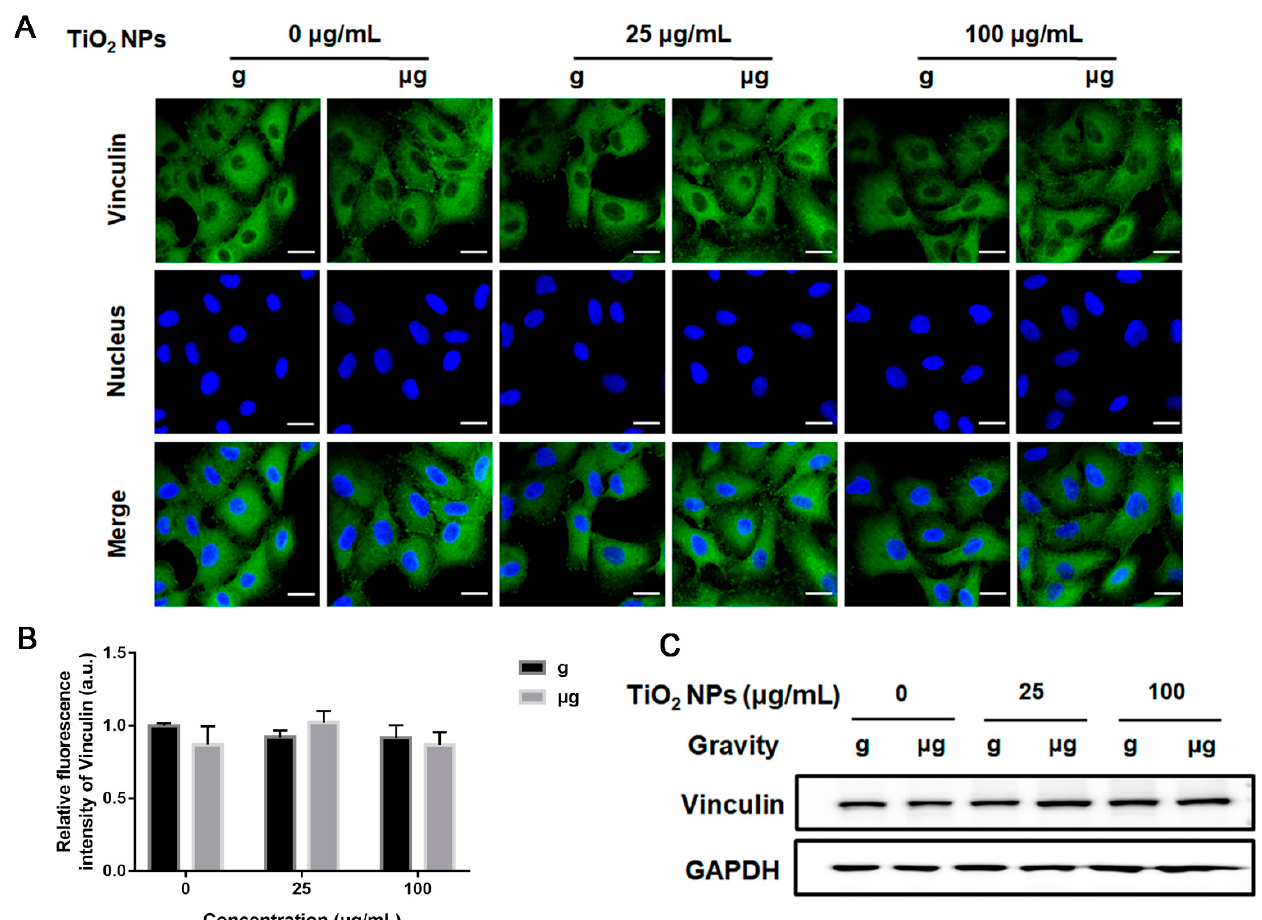
Figure 6. Effects of TiO 2 NPs exposure on the spatial distribution and expression level of vinculin. A549 cells were treated with TiO 2 NPs (0, 25 and 100 µ g/mL) for 48 h under normal gravity (g group) and simulated microgravity ( µ g group). ( A ) The harvested cells were subjected to immunofluores- cence staining for vinculin observation. DAPI was used to stain the nuclei (blue). The representative immunofluorescence images of cells with different treatments were demonstrated here (scale bar; 20 μ m). ( B ) The quantitative analysis of fluorescence intensity. ( C ) The representative results of Western blot analysis showing the expression level of vinculin in A549 cells of different groups.